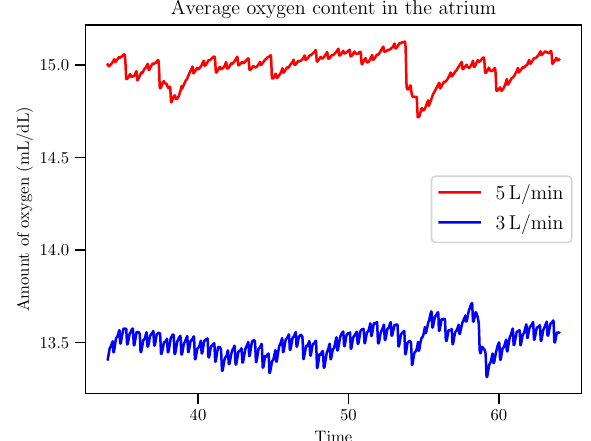
Figure 6. Total oxygen content in the right atrium during a sample simulation for the two ECMO flows we studied over the whole data-collection time interval. The plot shows that the difference in oxygen content in the atrium is sustained throughout the simulation and it is much bigger than the oscillations caused by the heart